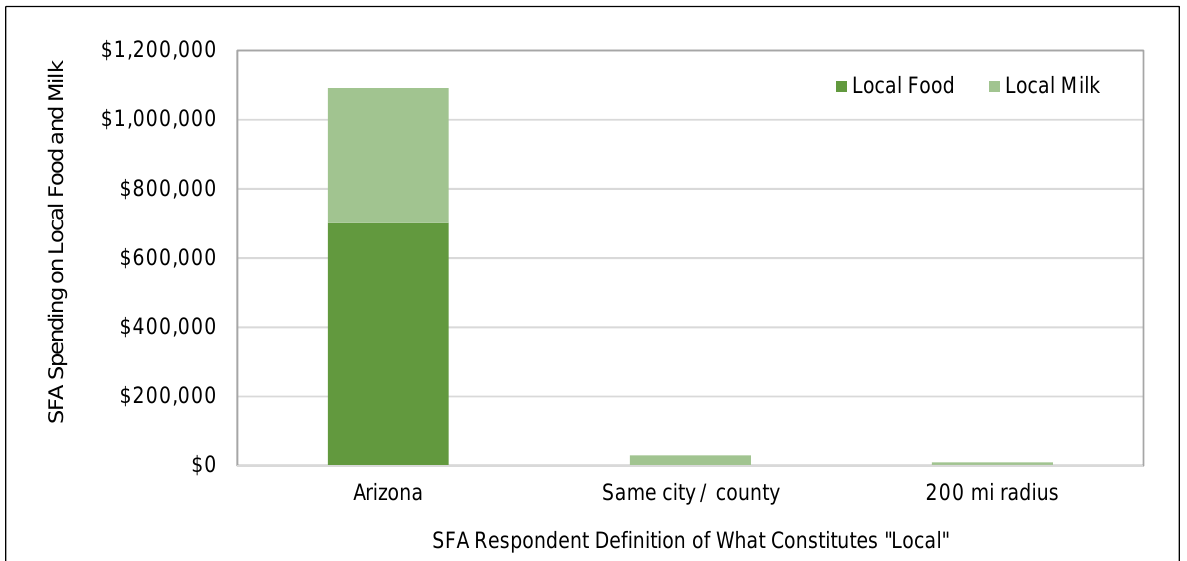
Figure 5. School Food Authorities’ (SFAs’) Local Food Spending (in US$) in Southern Arizona by Definition of Local (all in